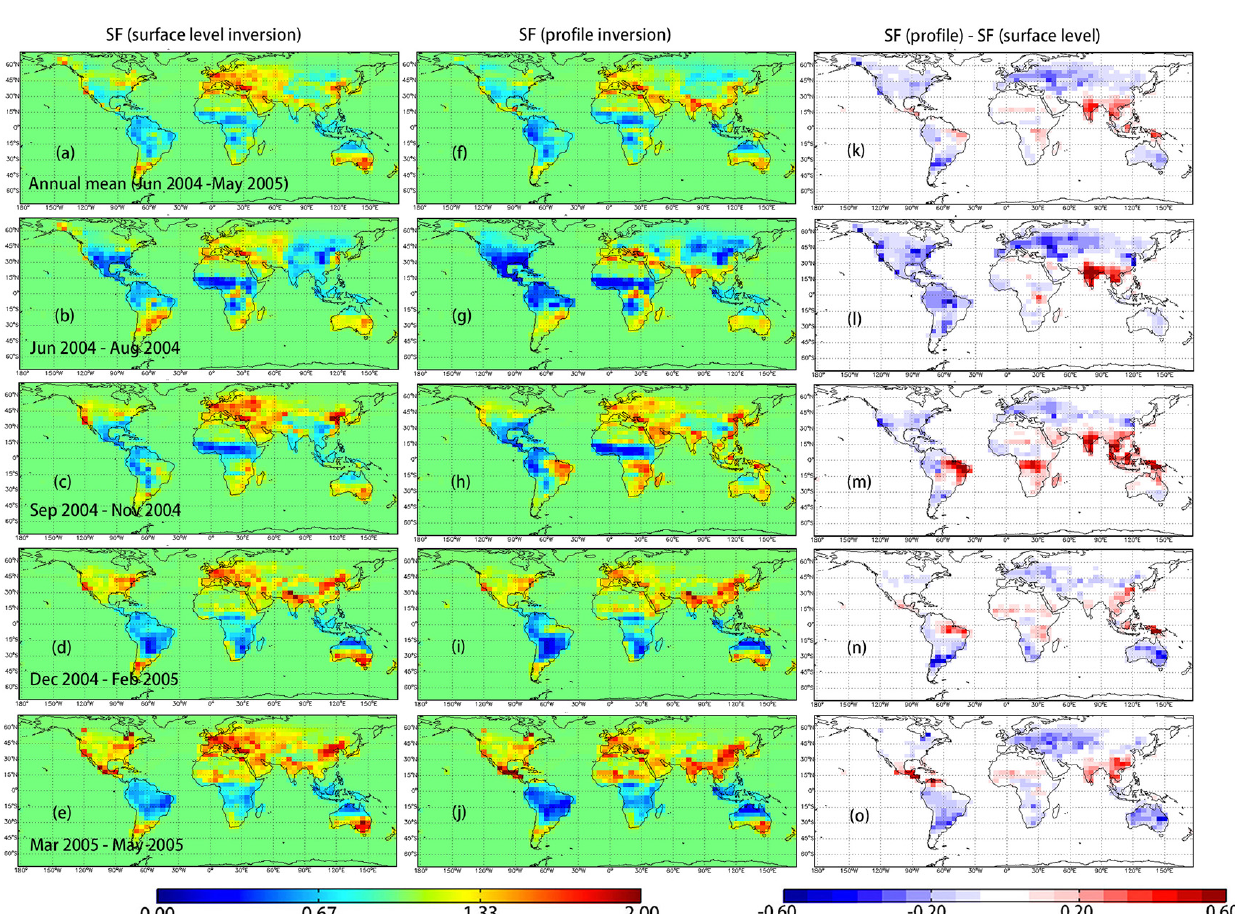
Figure 2. (a–e) Annual/seasonal mean scaling factors, using MOPITT V5J surface level data; (f–j) Annual/seasonal mean scaling factors, using MOPITT V5J tropospheric profile data; (k–o) Difference between two scaling factors, calculated by middle panel (f, g, h, i, j) minus left panel (a, b, c, d, e)